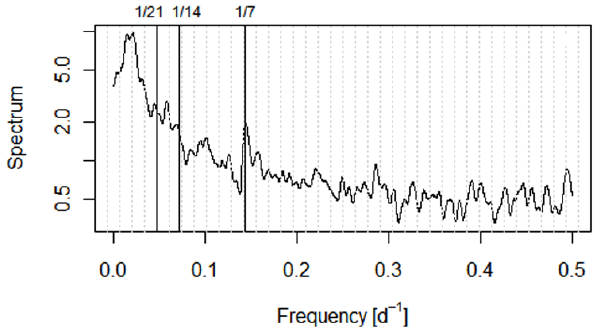
Fig. 4. Smoothed periodogram of NO 2 concentration (average of 4 EMEP stations in the Black Triangle) anomaly from 1983–2008. Solid vertical lines show the frequency of a week (1/7 days and multiples of it).